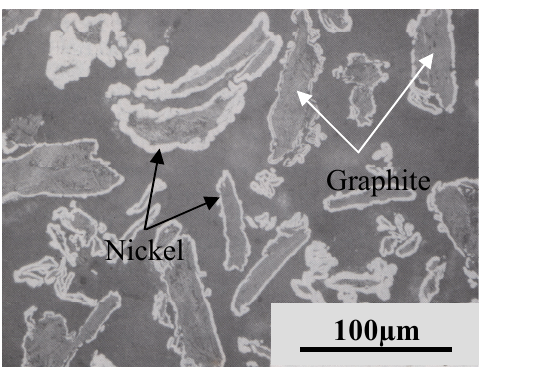
Figure 1 – (SEM) Scanning electron micrograph of Ni-25% graphite powder